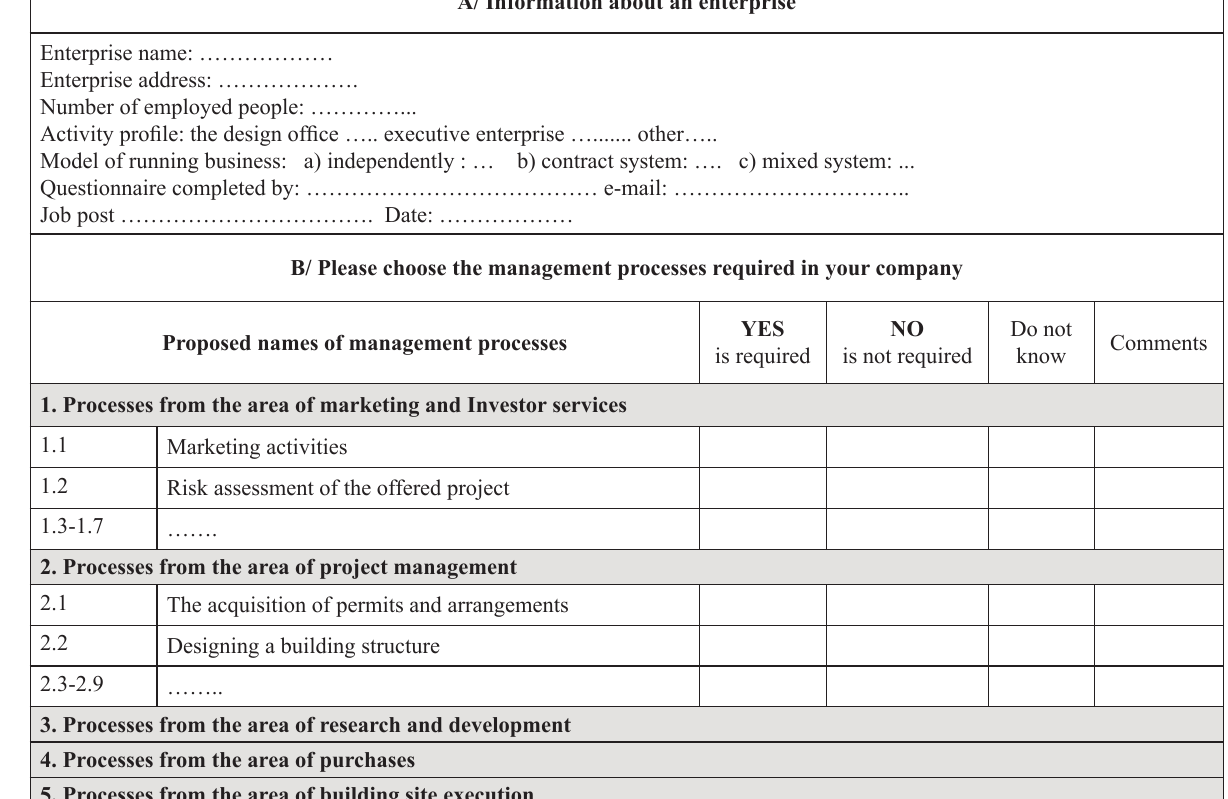
A/ Information about an enterprise